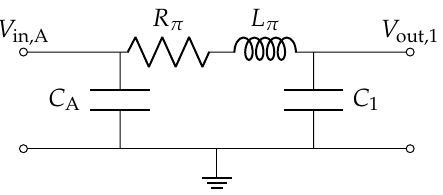
Figure 3. Schematic of the pi-line. For testing the components individually in a simple test case, voltage source and resistive load were added at the respective terminals. Table 1. Runtime of multi-level PinT compared to two-level and sequential time-stepping for the pi-line test